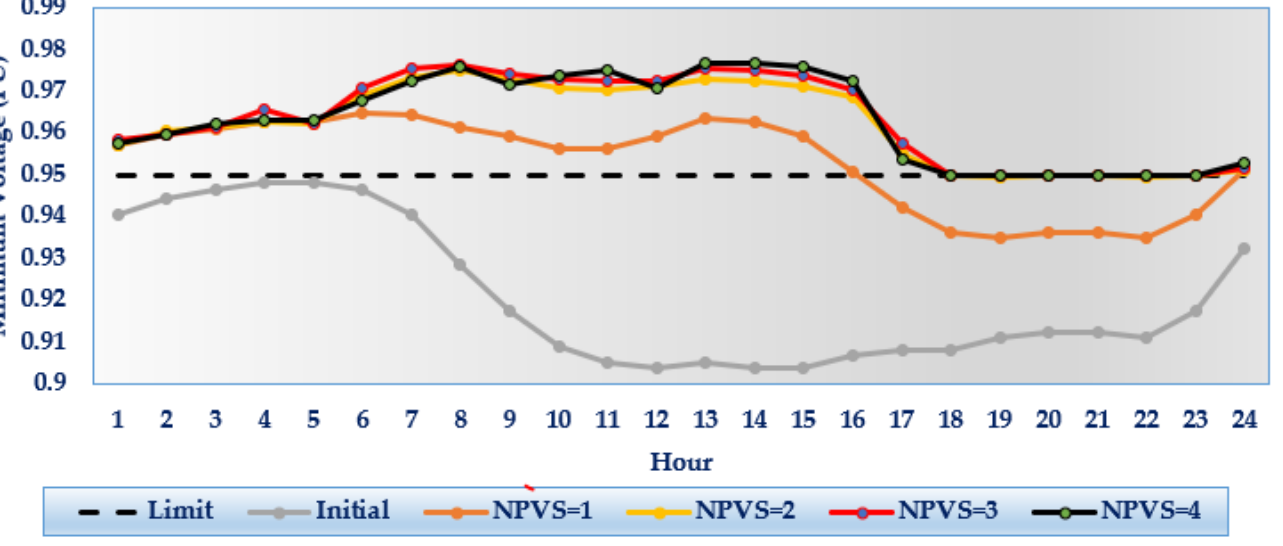
Figure 16. Hourly minimum voltage with varying the number of installed devices compared to the initial case for IEEE 69-feeder.